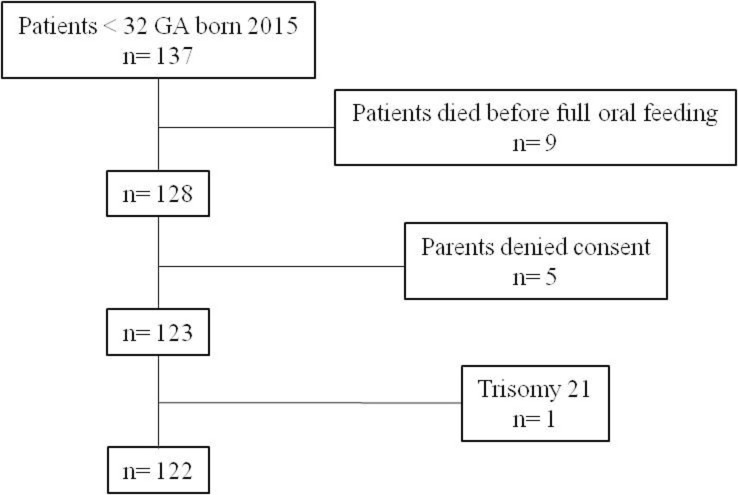
Flowchart of the study population.